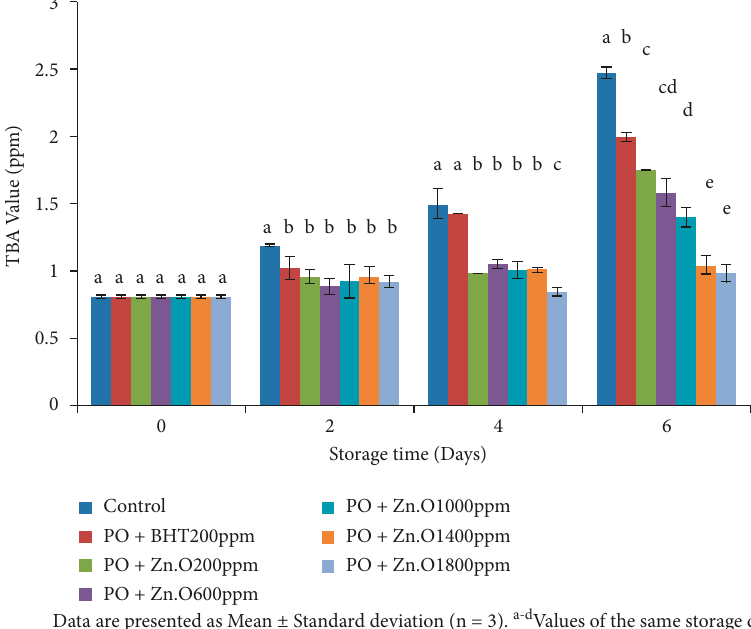
Figure 4: Variations in thiobarbituric acid value of palm olein enriched with different concentrations of ginger extract during storage at frying temperature. BHT: butylated hydroxytoluene; PO: palm olein; Zn.O: Zingiber officinale (ginger); control: palm olein without antioxidant; PO +BHT 200 ppm : palm olein+200ppm BHT; PO+Zn.O 200ppm : palm olein+200ppm ginger root extract; PO +Zn.O 600ppm : palm olein+600ppm ginger root extract; PO+Zn.O 1000ppm : palm olein +1000ppm ginger root extract; PO +Zn.O 1400ppm : palm olein+1400ppm ginger root extract; PO+Zn.O 1800ppm : palm olein+1800ppm ginger root extract. Values with different superscripts on the same days are significantly different at p < 0 . 05. Data are presented as mean ± standard deviation ( n � 3). a–e values of the same storage day with different superscripts differ significantly at p < 0 .